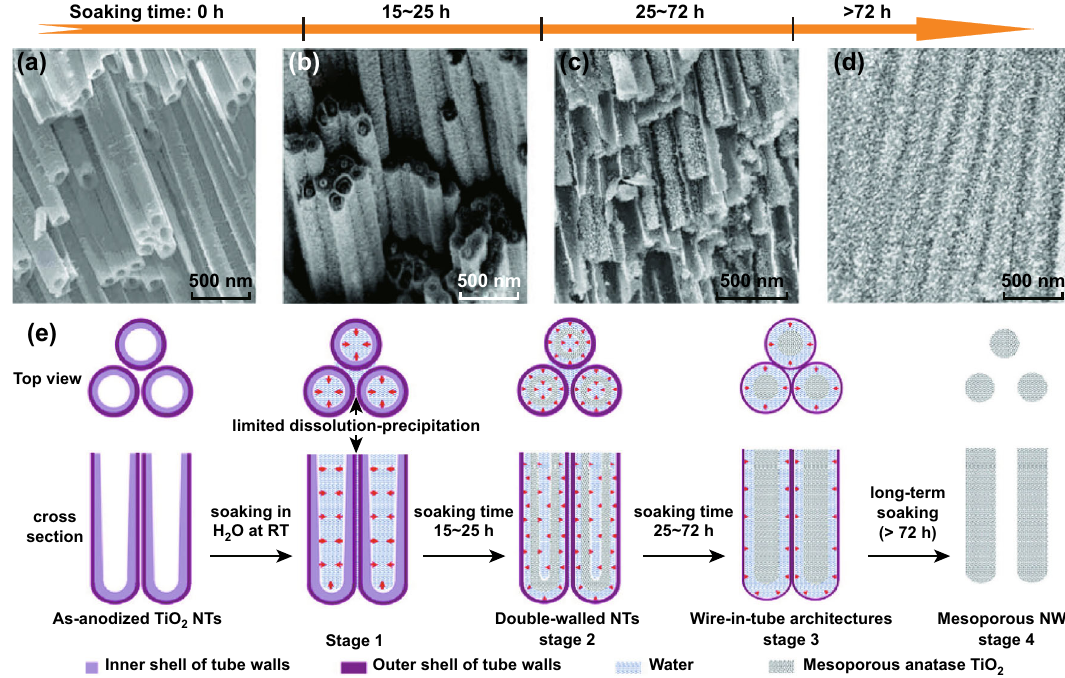
Fig. 9 SEM characterization of the morphological evolution as a function of water soaking time: a as-anodized TiO 2 nanotube arrays, b intermediate double-walled TiO 2 nanotube arrays obtained by water soaking for 15–25 h, c intermediate wire-in-tube TiO 2 nanoarchitecture formed by water soaking for 25–72 h, and d mesoporous TiO 2 nanowire arrays obtained by a long-term water soaking ( [ 72 h). e Scheme illustrating the morphology transformation of the as-anodized TiO 2 nanotubes upon water soaking. The red arrows denote the direction along which the dissolution–precipitation of TiO 6 octahedra proceeds [40]. Copyright (cid:2) 2011 American Chemical Society. (Color figure